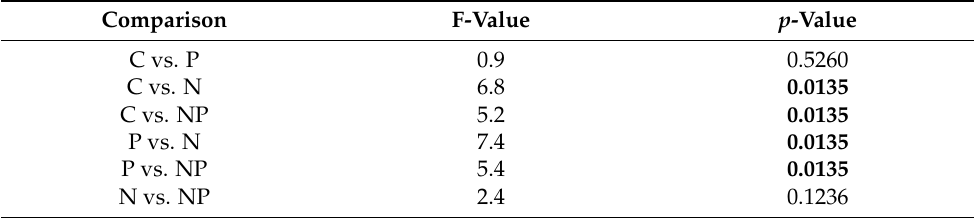
Table 1. Pairwise comparisons via PERMANOVA results for trait-based communities between nutrient enrichment treatments on coastal grassland. Bold indicates p < 0.05, using FDR correction.